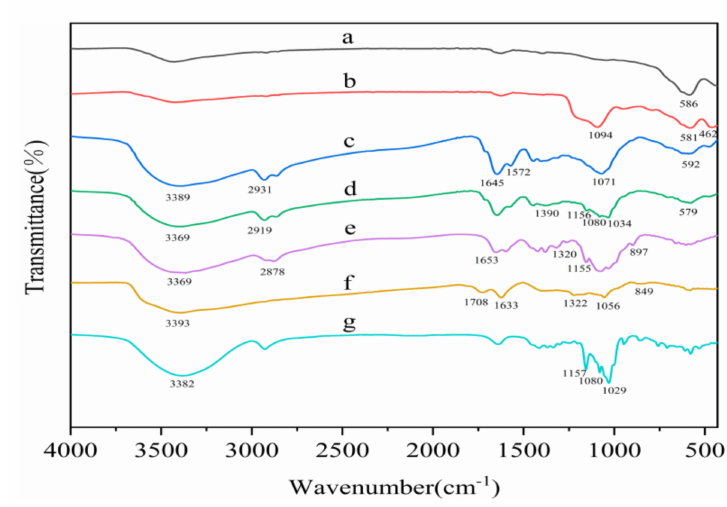
Figure 2. FTIR spectra of Fe 3 O 4 ( a ), Fe 3 O 4 @SiO 2 ( b ), Fe 3 O 4 @SiO 2 / CS ( c ), Fe 3 O 4 @SiO 2 / CS / GO / β -CD ( d ), CS ( e ), GO ( f ), and β -CD ( g